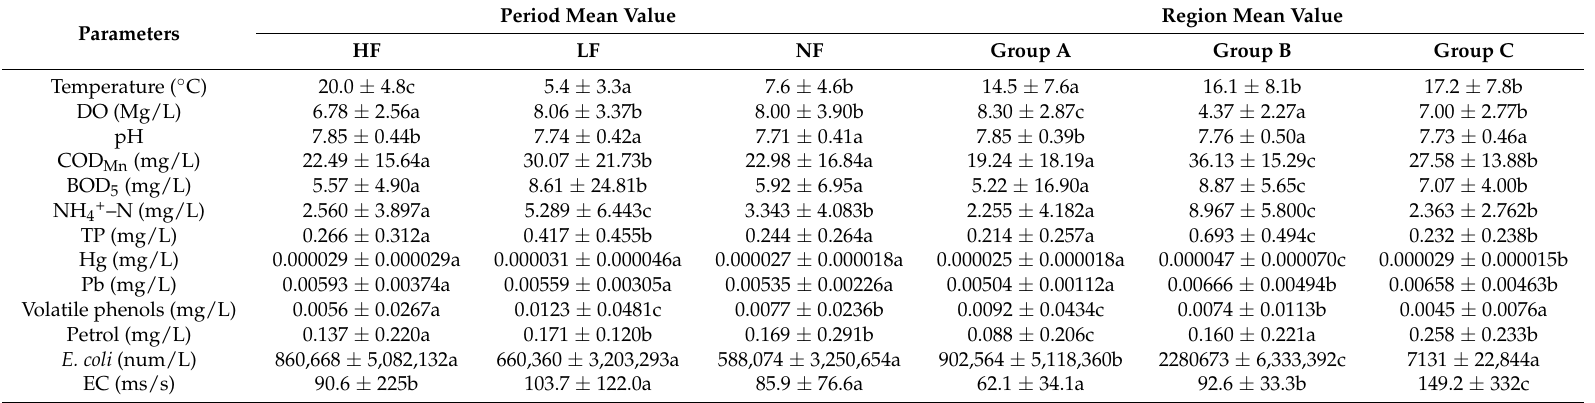
Table A3. Comparison of mean values of water quality parameters by ANOVA between pollution regions and